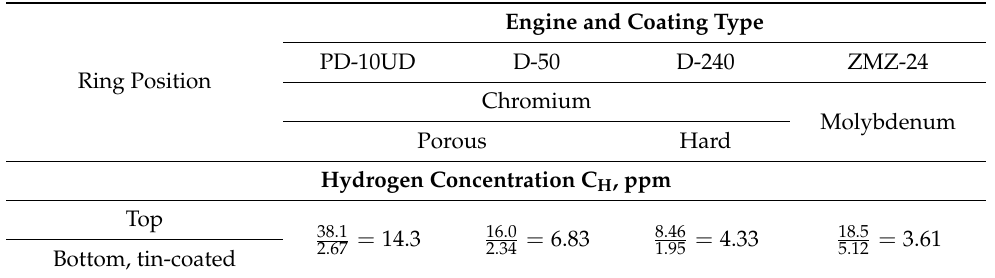
Table 3. The hydrogen concentration in piston rings.